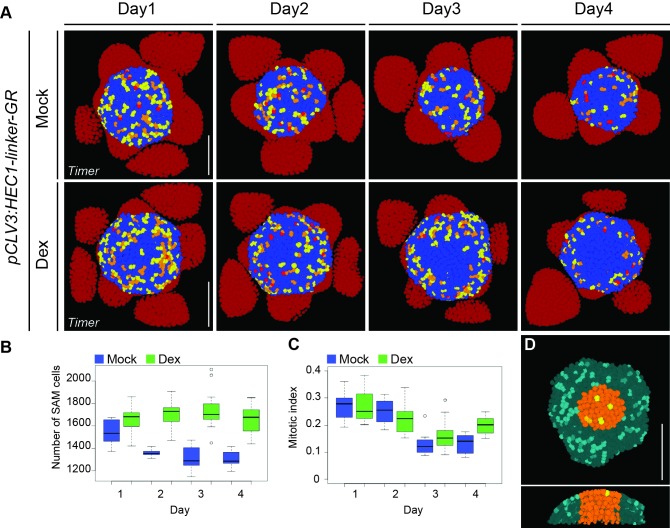
Dynamics of the SAM proliferative activity after HEC1-GR induction at the CZ.(A) Time series of 3D-reconstructed pCLV3:HEC1-linker-GR shoot meristems expressing pKNOLLE:fast-mFluorescentTimer-NLS after mock or dex treatment. Bright red, orange, yellow: young dividing cells; blue: older cells; dark red: primordia cells. Note that most cell division activity is detected at the peripheral zone (n > 7 per condition). (B) Development of the total SAM cell number in pCLV3:HEC1-linker-GR/pKNOLLE:fast-mFluorescentTimer-NLS SAM after mock (blue) or dex (green) treatment. (C) Time series quantification of mitotic index (young dividing cells/total SAM cells) in pCLV3:HEC1-linker-GR/pKNOLLE:fast-mFluorescentTimer-NLS after mock (blue) or dex (green) treatment. (D) 3D-segmented view of shoot meristem expressing pKNOLLE:fast-mFluorescentTimer-NLS and pUBQ10:3xGFP-NLS. The central domain (orange) and the periphery (cyan) of the SAM were quantified independently. Scale bar: 50 µm.